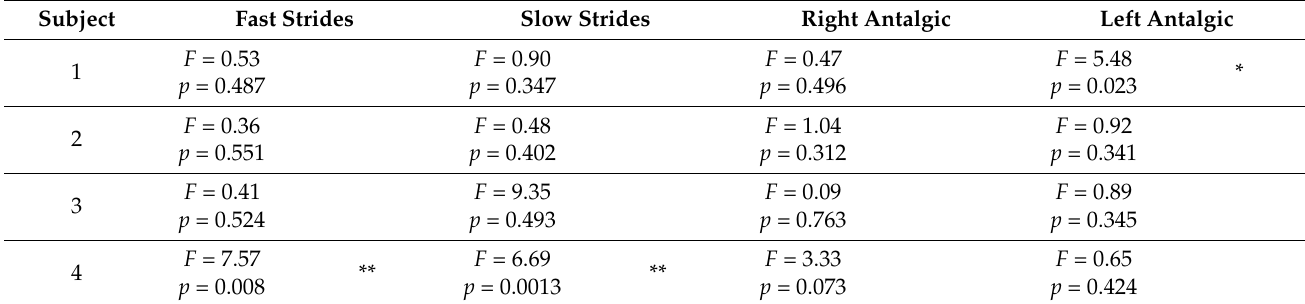
Table 12. Detection of Abnormal or Irregular Strides Using Cadence Variability (Levene’s